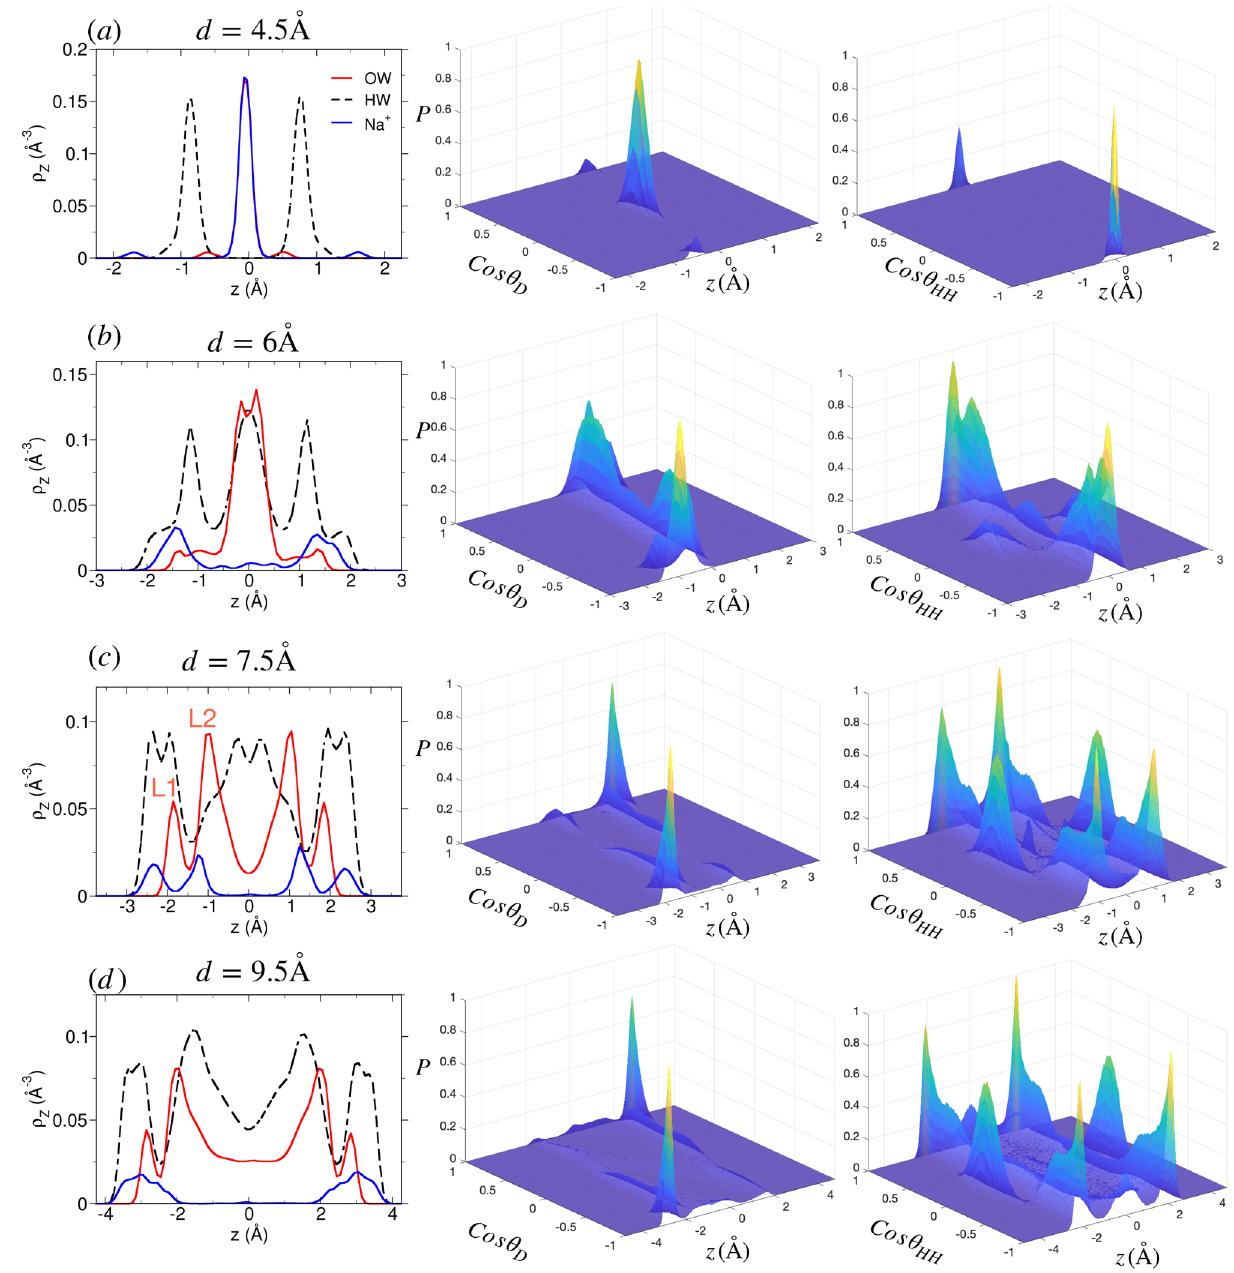
Figure 5. Structure of adsorbed water and cation in the Na-mica pores. (Left column) Density profiles of oxygen (red solid line) and hydrogen (black dashed line) of water molecules, and cations (blue solid line) for various pore widths of Na-mica system. In d = 4.5 Å, the oxygen (water) density profile is overlapped by the Na + ion density. Note the redistribution of Na + ions and layering of water with increase in d . L1 and L2 are the water layers (WLs) located closer to the surface. Probability distribution of cos θ D (middle column) and cos θ HH (right column) at various z -position within the pore. The P ( cos θ i , z ) reported were normalized by the maximum value observed in that confined (Fig. 4b). In addition to those, few water molecules hydrate more than one Na + ions simultaneously which gives rise to cos θ D = cos θ HH ≈ 0 (Fig. 5b). At d = 7.5 Å, the Na + ion density near surface splits into two peaks, albeit, both forming ISCs with water molecules ( ISC 1 is closer to surface than ISC 2 ). Similarly, the water mol- ecules also exhibits two individual peaks, L1 and L2, adjacent to each mica surface (Fig. 5c). The L1 water mol- ecules are those which are adsorbed in ion-free cavities of mica surface with water hydrogen forming hydrogen bonds with surface oxygen atoms due to which they make cos θ D = ± 1 and cos θ HH = 0 (Fig. 4b). The P ( cos θ D ) of L2 water molecules is much broader and distributed, however, the P ( cos θ HH ) exhibits strong peaks in the range of cos θ HH = 0.25 − 1 (Fig. 5c). The reason for the above observation is the formation of hydrogen bonds